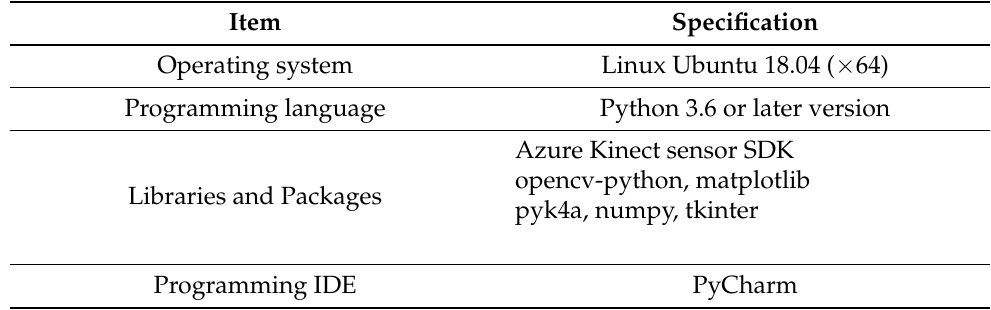
Table 7. Development